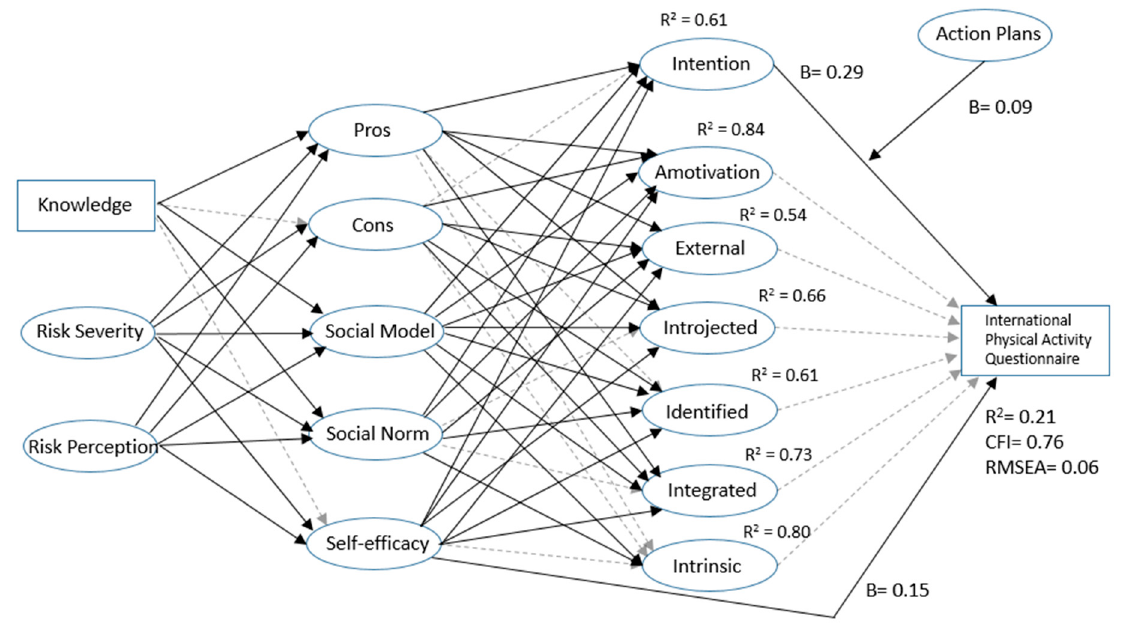
Figure 3. Unstandardized regression coefficients for the integrated model.